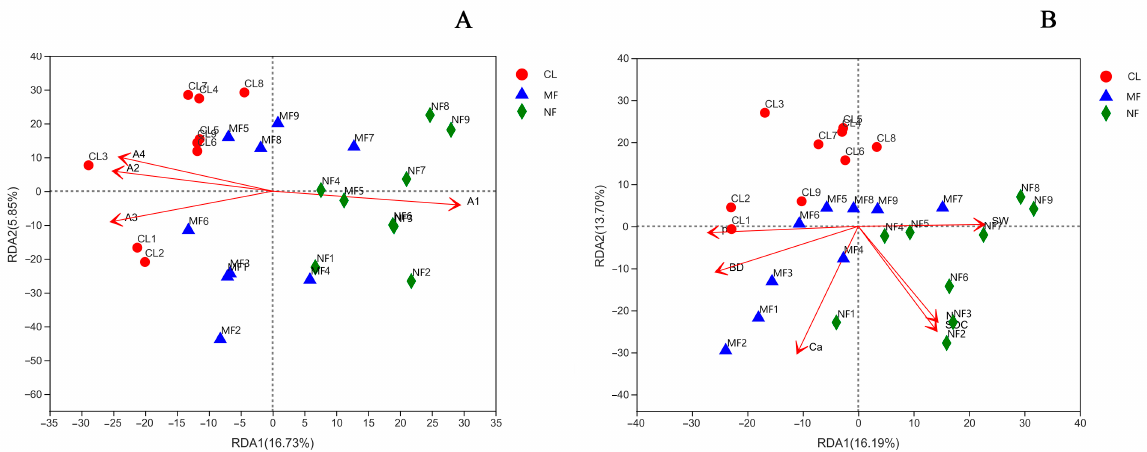
Figure 5. Redundancy analysis (RDA) of the soil bacterial communities with respect to the ( A ) soil aggregates and ( B ) soil properties. NF—natural secondary forest; MF—managed forest; CL—cropland.